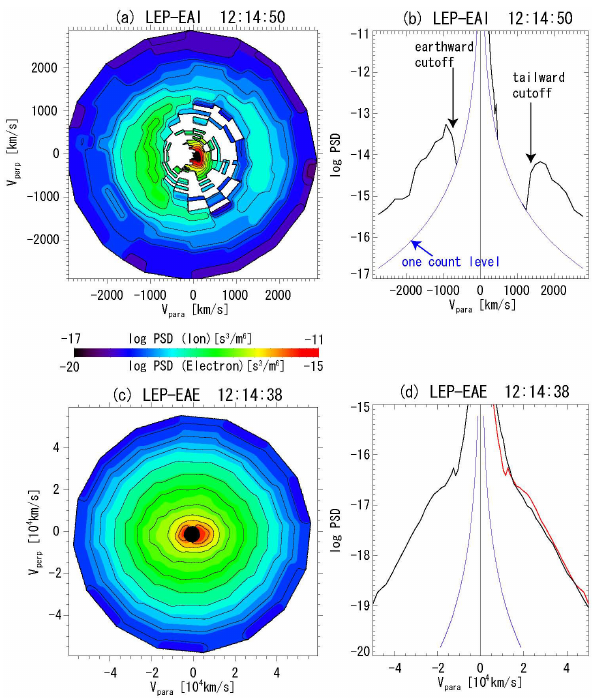
Fig. 4. (a) Ion velocity distribution in the B-C plane at 12:14 UT, (b) 1-D cut of ion velocity distribution at the B-axis, (c) 2-D cut of electron velocity distribution at 12:14 UT, (d) 1-D cut of the elec- tron velocity distribution at the B-axis at 12:14 UT. Red line shows the mirror image of the opposite side.